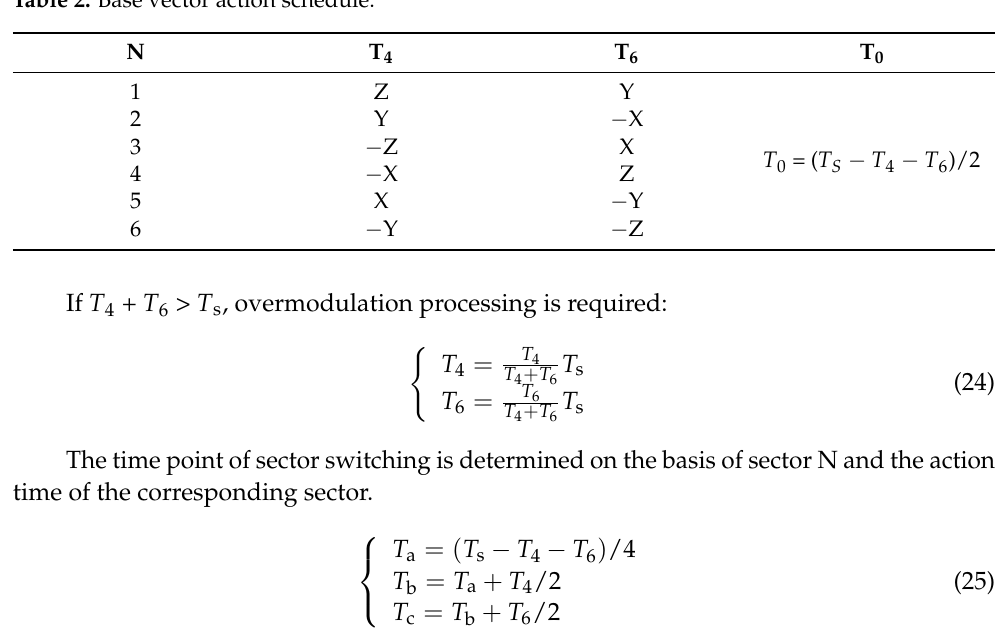
Table 2. Base vector action schedule.